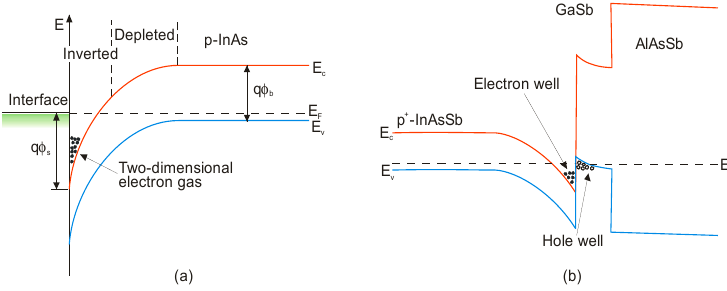
Figure 11. Band edges of p-type InAs and InAsSb with surface electron accumulation: ( a ) InAs with surface inversion layer; the electrostatic potential has the value Φ s at surface and Φ b in the bulk, ( b ) InAsSb/AlAsSb heterojunction with depicting surface electrons, epilayer, and interface with AlAsSb.